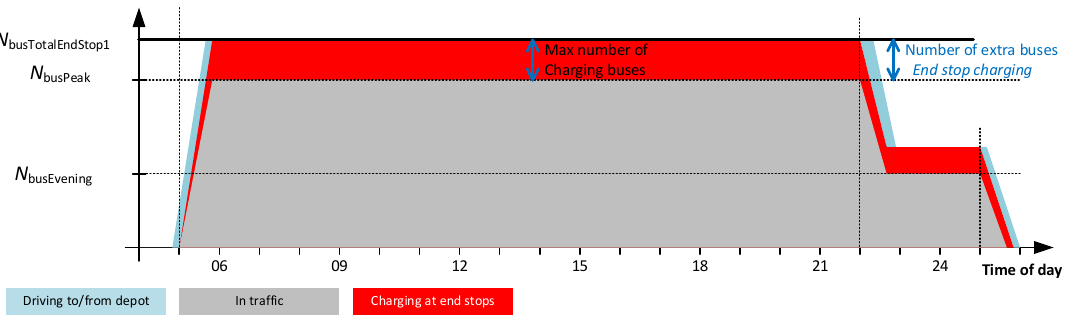
Figure 10. How the number of buses during peak traffic cannot be reduced if the off ‐ peak traffic is the same as the peak traffic.